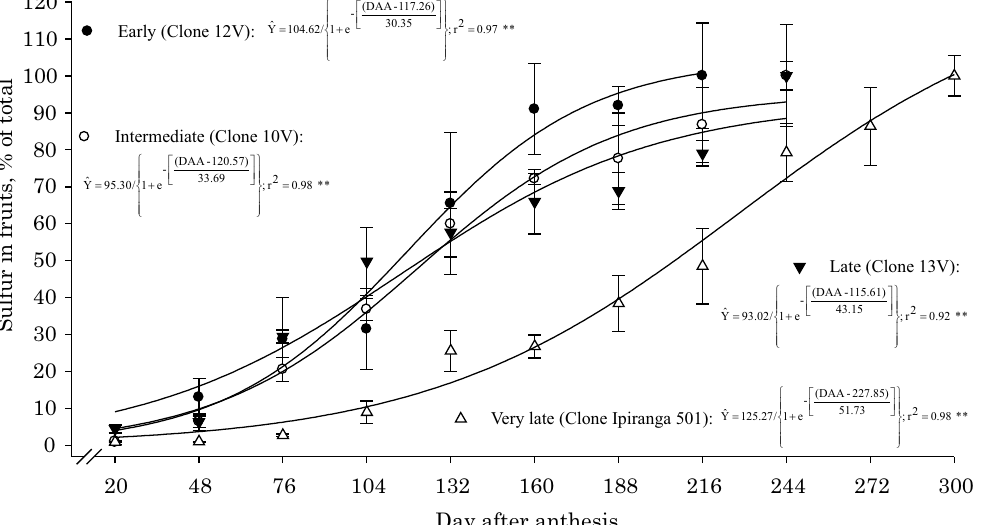
Figure 7. Accumulation of sulphur in fruits (in percentage of the cumulative total) of four genotypes (clones) of Conilon coffee, from anthesis to fruit maturation. The bars refer to the standard error of the average. ** significant at 1 %